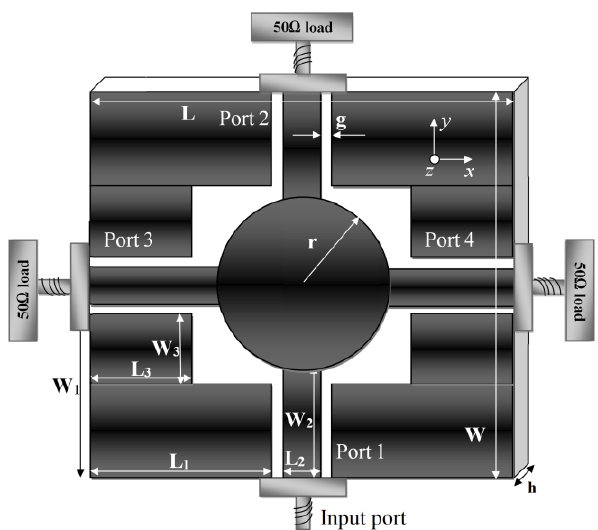
Figure 1: Geometry of the proposed pattern diversity antenna.